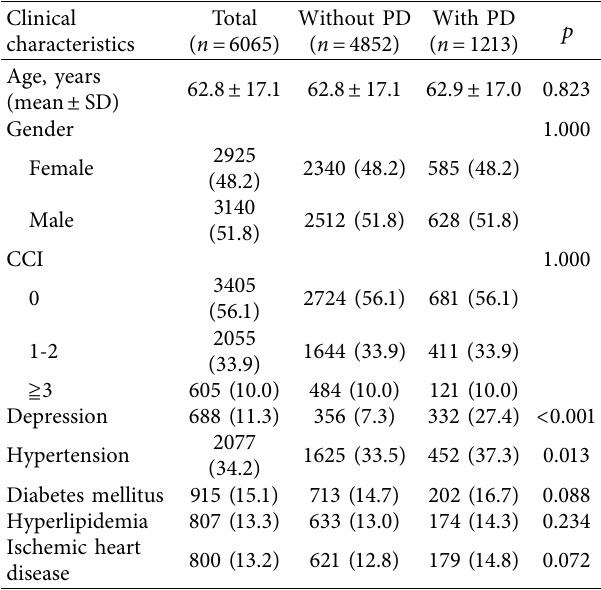
Table 1: Clinical characteristics of study